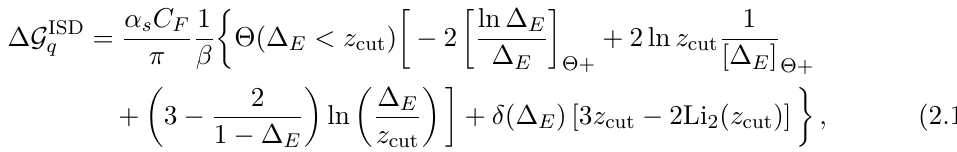
Figure 3 . Comparison of the full one-loop result for jet function for iterated soft drop ∆ G ISD red), its singular (dashed blue) and non-singular terms (dotted green), for jets initiated by quarks (left) and gluons